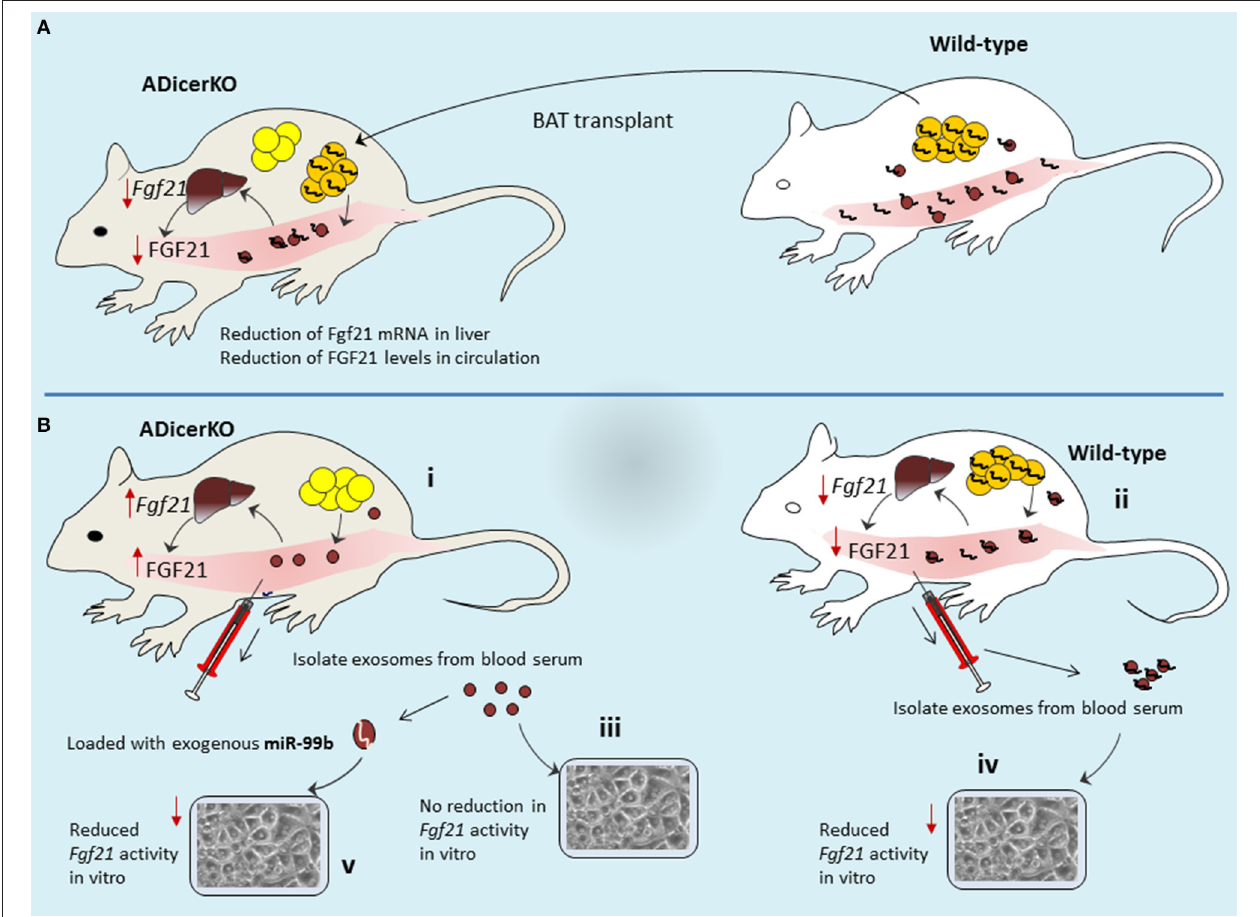
FIGURE 4 | Mechanisms of long distance inter-organ cross-talk. (A) BAT transplant provides the source of miRNAs in recipient mice that then are circulated to liver where they elicit gene regulation. (B) Adipose tissue of ADicerKO-mice is providing no miRNA in circulation, thus allowing the higher expression of FGF2 in liver (B-i) , as compared to wild-type which contributes abundance of miRNA in circulation that are delivered to liver and thereby supress FGf21 -mRNA and thus less secretion of FGF21 protein (B-ii) . Transfer of serum exosomal-miRNAs to in-vitro settings reflected the corresponding activity of exosomes from ADicerKO-mice (no affect; B-iii ) and wild-type (reduction of Fgf21 activity; B-iv ). However, loading of miR-99b into exosomes of ADicerKO-mice mimicked the activity of exosomes from